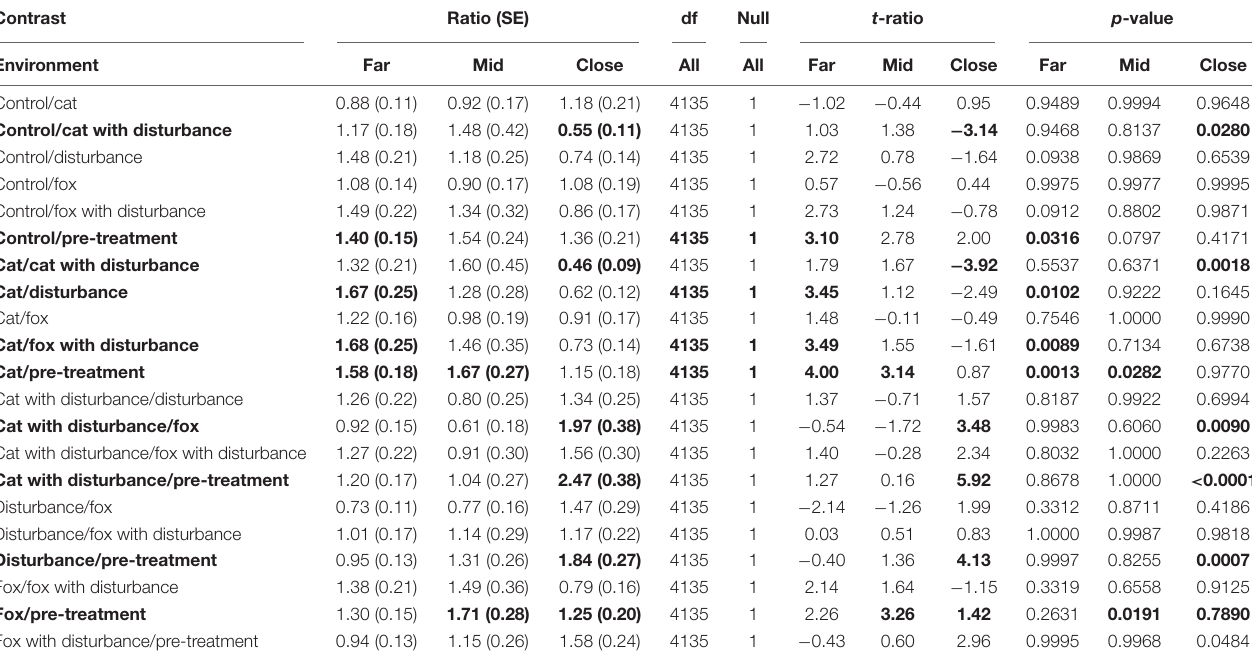
TABLE 5 | Between treatment pairwise contrast ratios for estimated marginal means from generalized linear mixed models with zero inflation and dispersion parameters for the proportion of time spent vigilant, under the explanatory variables of treatment and environment. Contrast Ratio (SE)